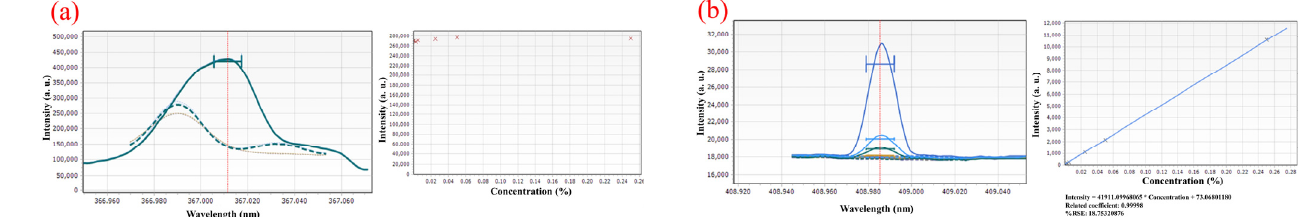
Figure 4. Element spectrum of U in ( a ) 409.013 nm; ( b ) 367.007 nm.